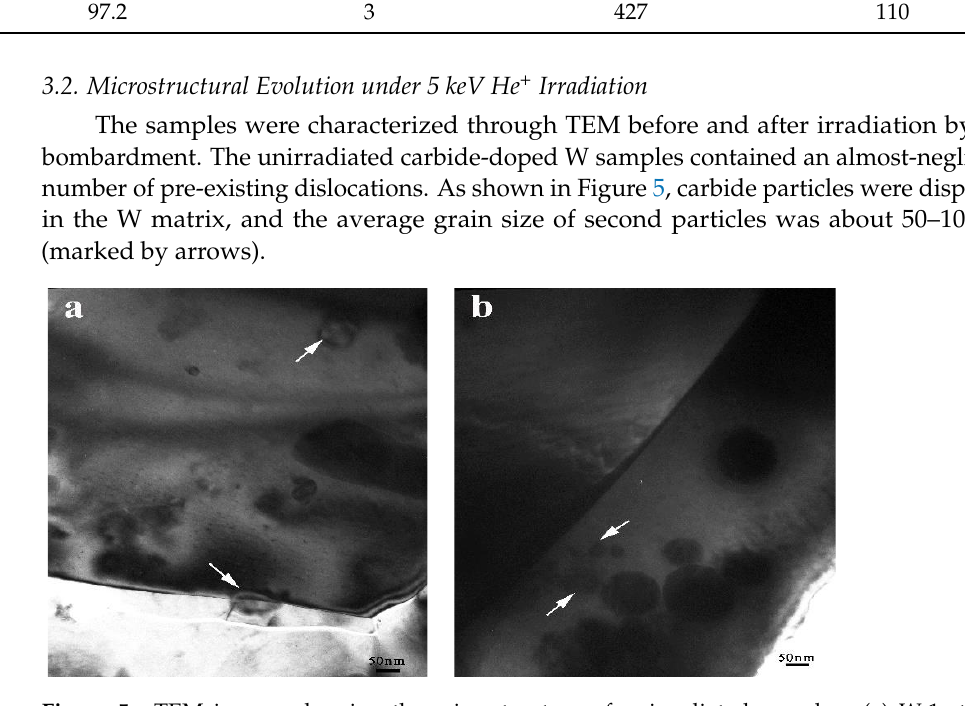
Figure 5. TEM images showing the microstructure of unirradiated samples: ( a ) W-1wt%TiC, ( b ) W- 1wt%ZrC. ( b )